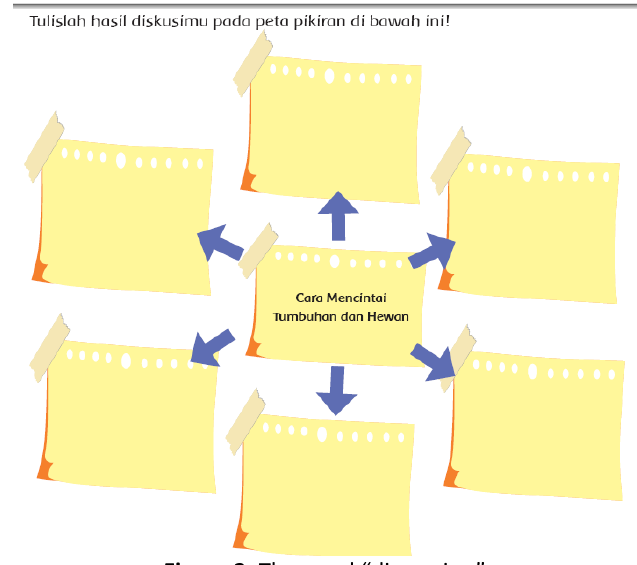
Figure 3: The word